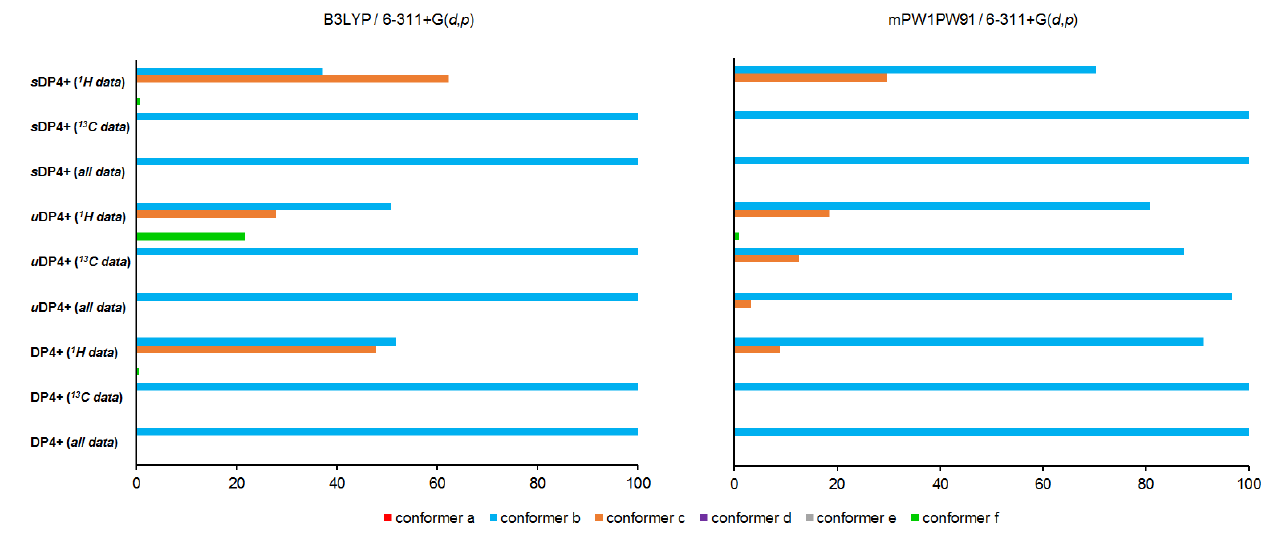
Figure 5. Graphs of the DP4+ probability distribution (%) of the conformers of alasmontamine A, obtained by correlating calculated vs. experimental NMR data. Minor isomers with a molar fraction of less than 1% are not visible on the diagram. s DP4+ denotes scaled values of DP4+; u DP4+ denotes unscaled values of DP4+ (see Section 3.4 for details).